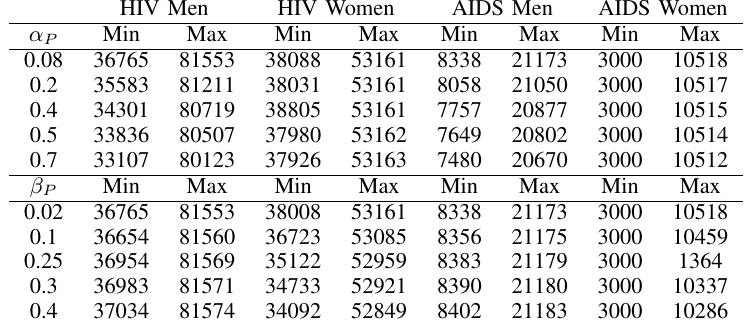
Table V: Minimum and maximum values for α P and β P for the different HIV/AIDS compartments.